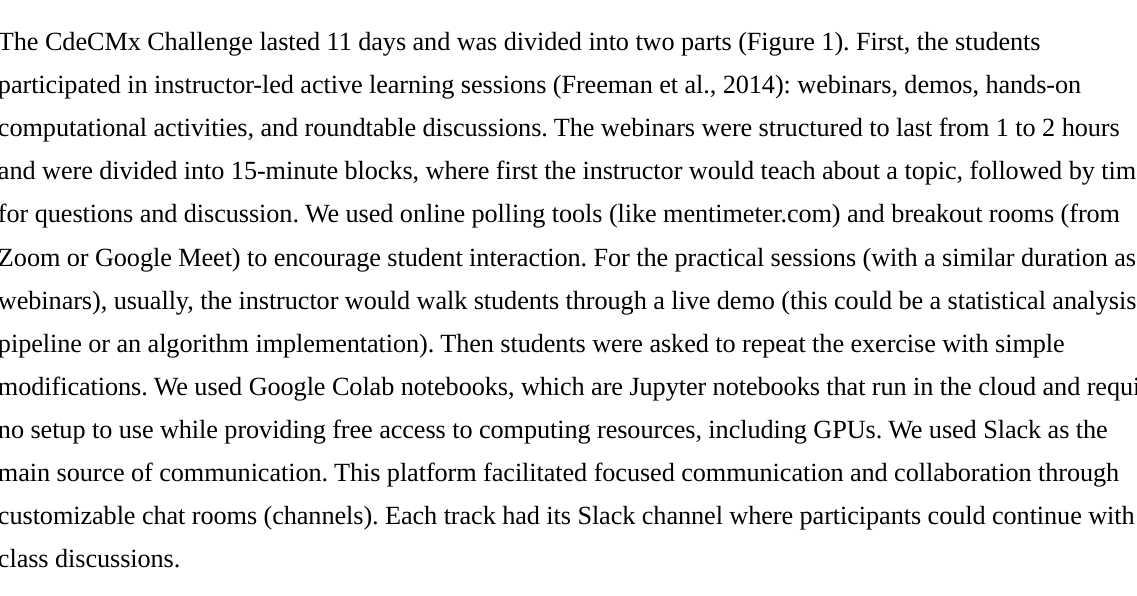
Figure 2. A snapshot of instructors that participated in our 2020 program. A) Statistics on the country of residence, nationality, and gender. B) Academic area of study from instructors. The main disciplines in the different areas were formal sciences (physics 100%), natural sciences (biology 29%), engineering and technology (bioengineering and biotechnology 55%), and medical and health sciences (medicine and public health